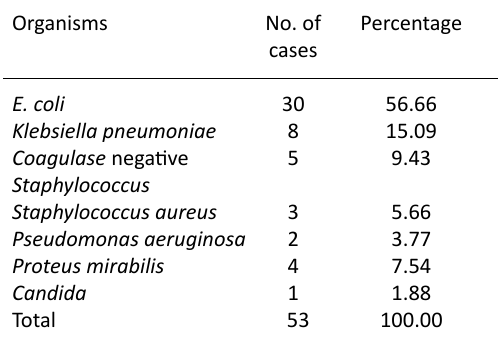
Table 6. Antibiotic Sensitivity test